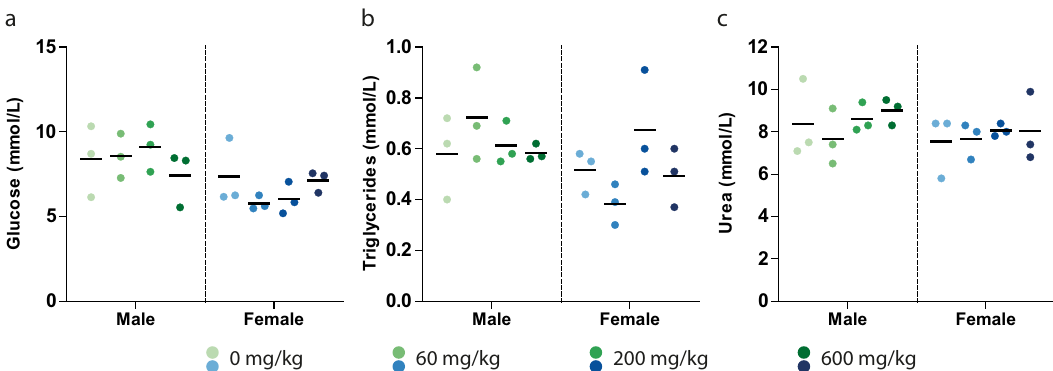
Fig. 5 In vivo safety of MMV693183. a – c Evidence of in vivo toxicity was examined in male and female Wister Han rats ( N = 3 per condition) treated for seven days with MMV693183. Glucose ( a ), triglycerides ( b ) and urea ( c ) concentrations were measured in rats (male or female) treated with different doses of MMV693183. Signi fi cance was determined using One-Way ANOVAs with the Bonferroni ’ s Multiple Comparison Test, but none were signi fi cant. Source data are provided as Source Data fi